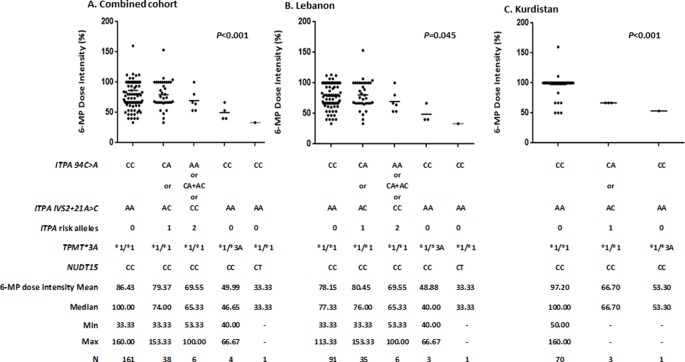
Association1 between ITPA, TPMT, NUDT15 genetic polymorphisms and 6-mercaptopurine (6-MP) dose intensity2 during maintenance therapy in (A) Combined cohorts (N = 210), (B) Lebanon cohort (N = 136), and (C) Kurdistan cohort (N = 74). 1Kruskall Wallis test; Horizontal lines indicate the mean. 2Lebanon: ratio of the MP dose reached during maintenance therapy to maintain the WBC between 1,500 and 3,000 per µl and the ANC > 300 per µl to that of the maintenance prescribed MP dose as per protocol. Kurdistan: ratio of the MP dose reached during maintenance therapy to maintain the WBC between 2,000 and 3,000 per µl and the ANC > 500 per µl to that of the maintenance prescribed MP dose as per protocol.